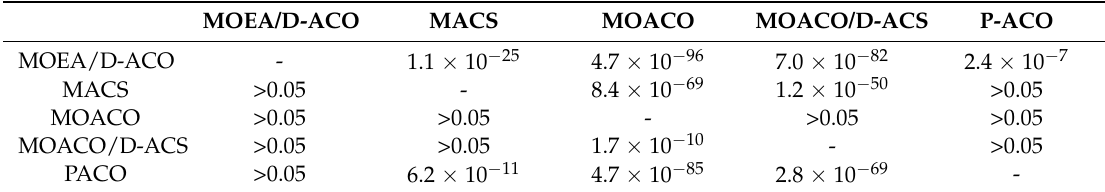
Table 8. Kruskal–Wallis test on euclidAB100 based on H-indicator.